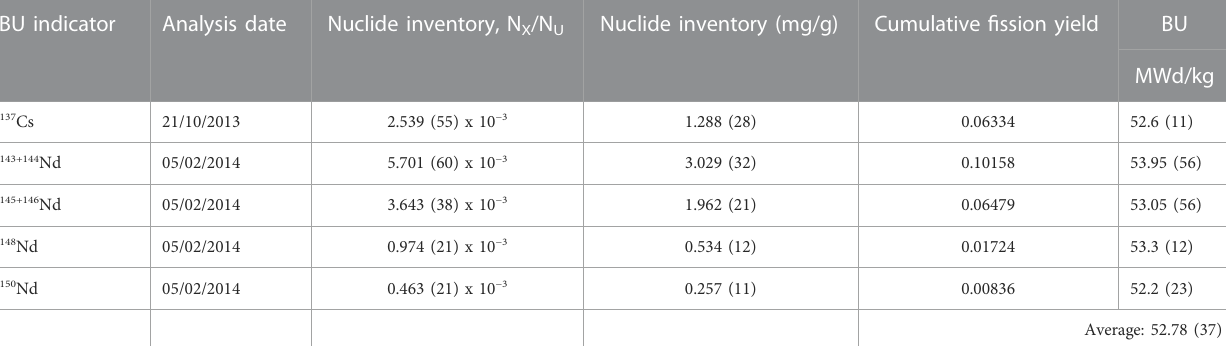
TABLE 2 Results of a radiochemical analysis of a SNF segment sample taken in the region between 1819 mm and 1842 mm for a cooling time of 4,630 days (Adriaensen and Dobney, 2020). The nuclide inventory (N X ) is expressed relative to the initial number of U atoms (N U ) and relative to the total weight of the fuel, i.e., including the oxygen. The BU is expressed relative to the initial amount of uranium. The irradiation-averaged fi ssion yields were calculated using the irradiationhistoryas input (Eysermans etal.,2022;Eysermans andVerwerft, 2022) according to the method described in(Govers etal.,2022). TheBU values were derived from the inventory assuming 200 MeV per fi ssion. The uncertainties of the BU re fl ect solely those of the nuclide